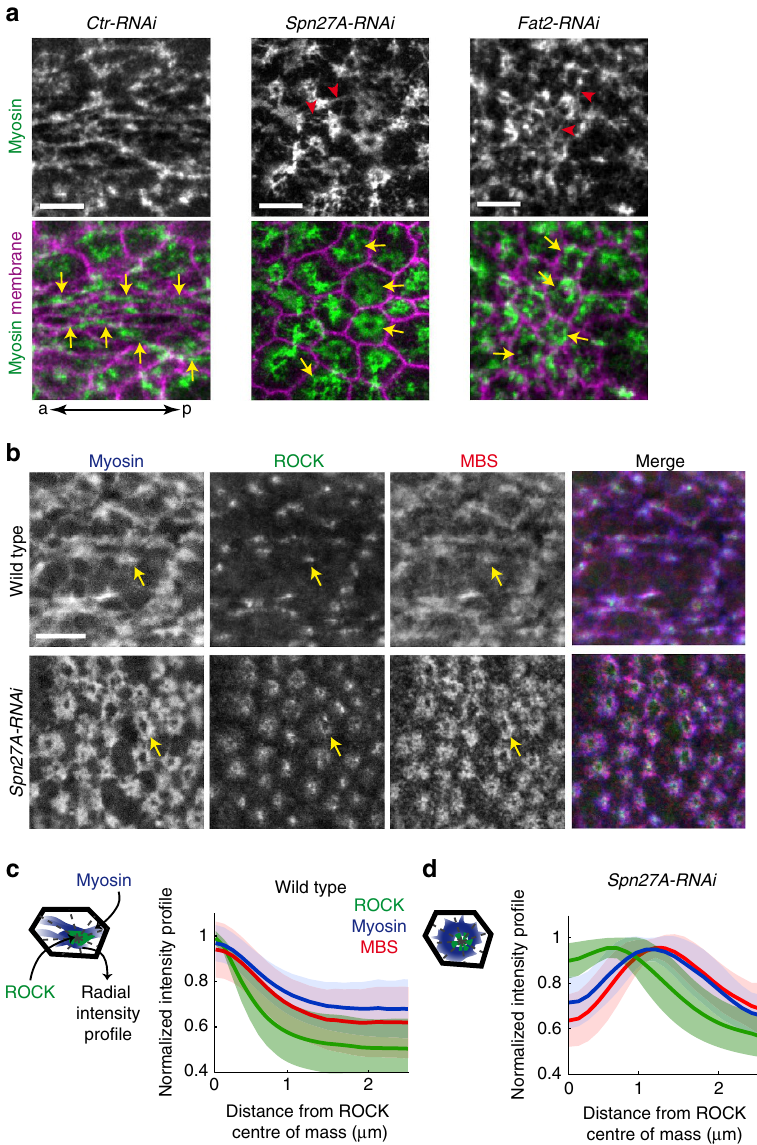
Figure 3 | Change in tissue shape induces alternative configuration of the ROCK-myosin signalling module. ( a ) Apical myosin meshwork (green) organized into a-p oriented fibres during VF formation in Ctr-RNAi embryos (arrows) but organized into rings in Spn27A-RNAi and Fat2-RNAi embryos (arrows). Red arrowheads point to radially oriented spokes that connected myosin rings from cell to cell. a, anterior; p, posterior. ( b ) Images of VF cells in fixed wild-type and Spn27A-RNAi embryos showing the localization of ROCK::GFP (green) sqh::mCherry (blue) and MBS (red). Myosin and MBS formed a fibrous network and ROCK a condensed focus in wild-type cells (arrow), whereas Myosin, MBS and ROCK organized into rings in Spn27A-RNAi cells (arrow). ( c , d ) Quantification of ROCK, myosin and MBS polarization in the apical domain of VF cells as the signal intensity profile from the centre of ROCK density to the apical margin. Left, schematic of cells with radial lines emanating from the ROCK centre of mass. Right, mean normalized intensity profile of ROCK, myosin and MBS in wild-type cells ( c , n ¼ 152 cells, one embryo) and Spn27A-RNAi cells with clear ROCK rings ( d , n ¼ 27 cells, one embryo). Shaded area indicates s.d. Scale bars, 5 m m ( a ) and 10 m m ( b